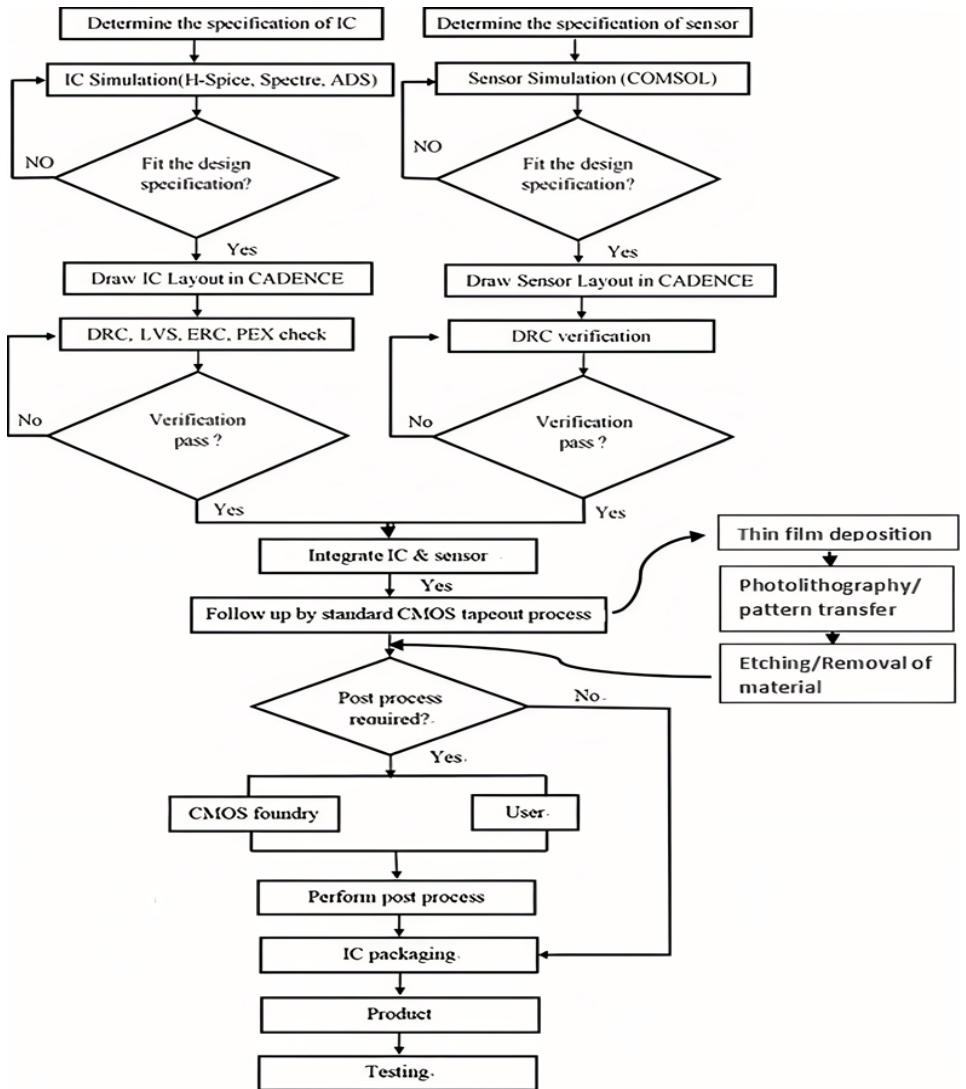
Figure 6. CMOS microsensor fabrication process. Analysis of analog circuit behavior is performed by H-Spice, Spectre, and ADS software; analysis of simulated sensor behavior is performed by COMSOL or ANSYS, which is combined with related sensing principles. Both the circuit layout and sensor layout use the same CMOS material layers. However, in the layout verification part, the sensor must pass DRC at most (under some special conditions can even relax certain DRC rules).